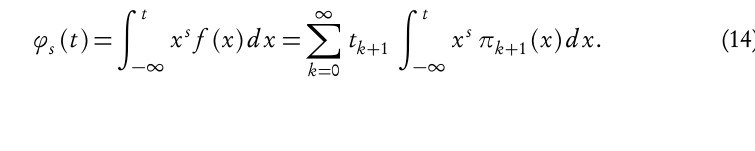
Figure 4 – Skewness (left panel) and kurtosis (right panel) of MOG-LL distribution. Similarly, the s th incomplete moment, say ϕ